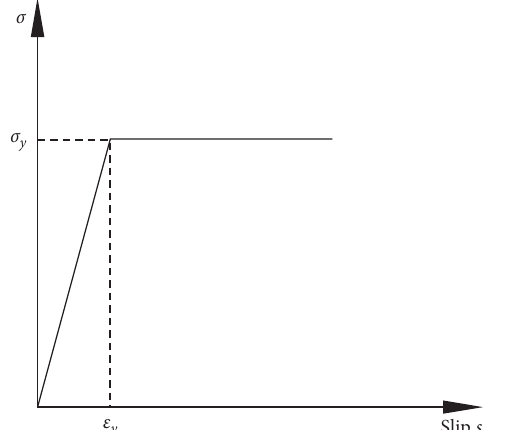
Figure 12: Typical bond-slip